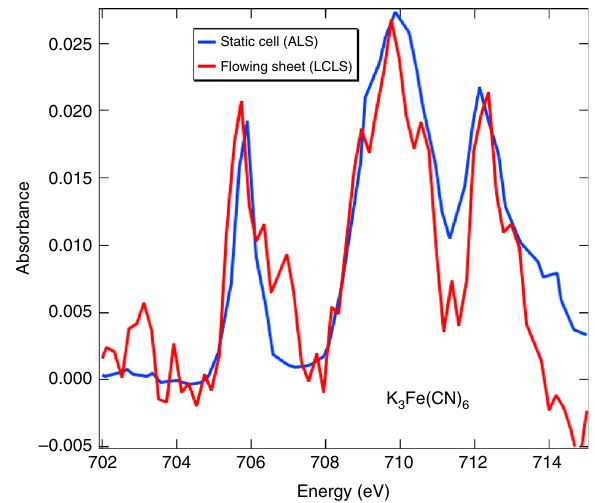
Fig. 7 Soft X-ray transmission spectroscopy of aqueous sheets. Soft X-ray transmission spectra for 100 mM Fe(CN) 6 (3 − ) measured at the ALS in a static cell (blue), and at the LCLS in a fl owing ultrathin liquid sheet (red) are shown. The ALS data was scaled down to compare to the absorbance of the